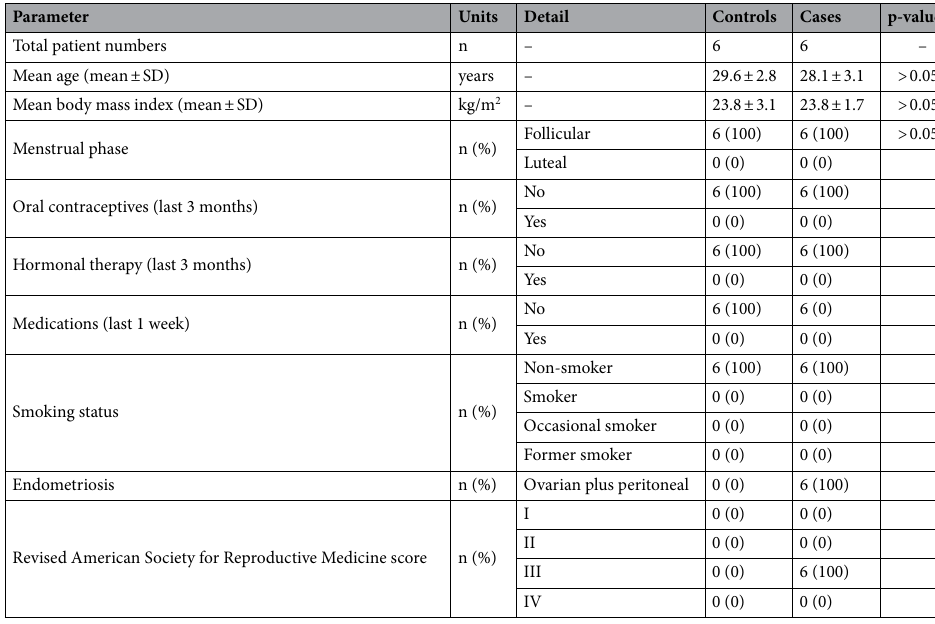
Table 1. Clinical characteristics of the 12 patients included in the discovery